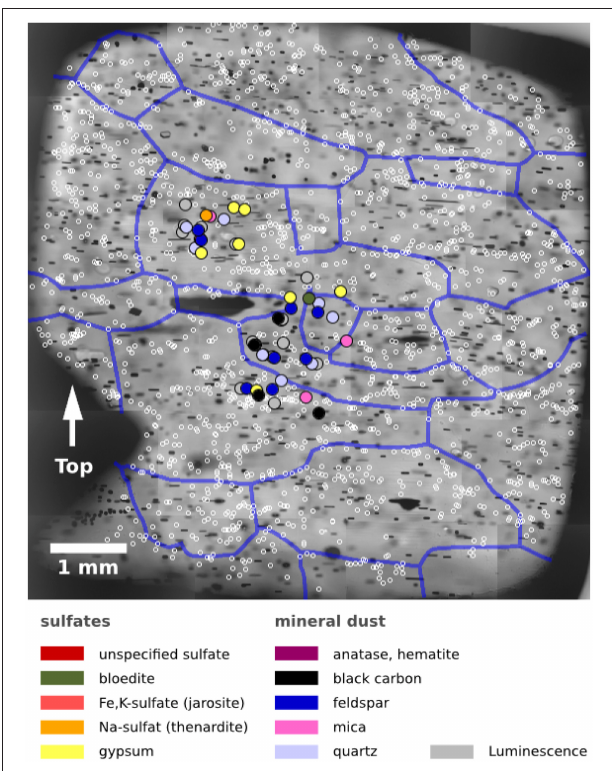
FIGURE 6 | Impurity map in section 2392-2 (2392.26 m). The impurity analysis of the MIS6 sample was restricted to an area of approximately 8 × 8 mm 2 . White circles represent positions of individual micro-inclusions. Colored circles indicate micro-inclusions analyzed with the Raman system. Gray circles represent micro-inclusions with strong luminescence. Blue bands indicate positions of grain boundaries at the upper surface, approximately 300 microns above the focus depth of the